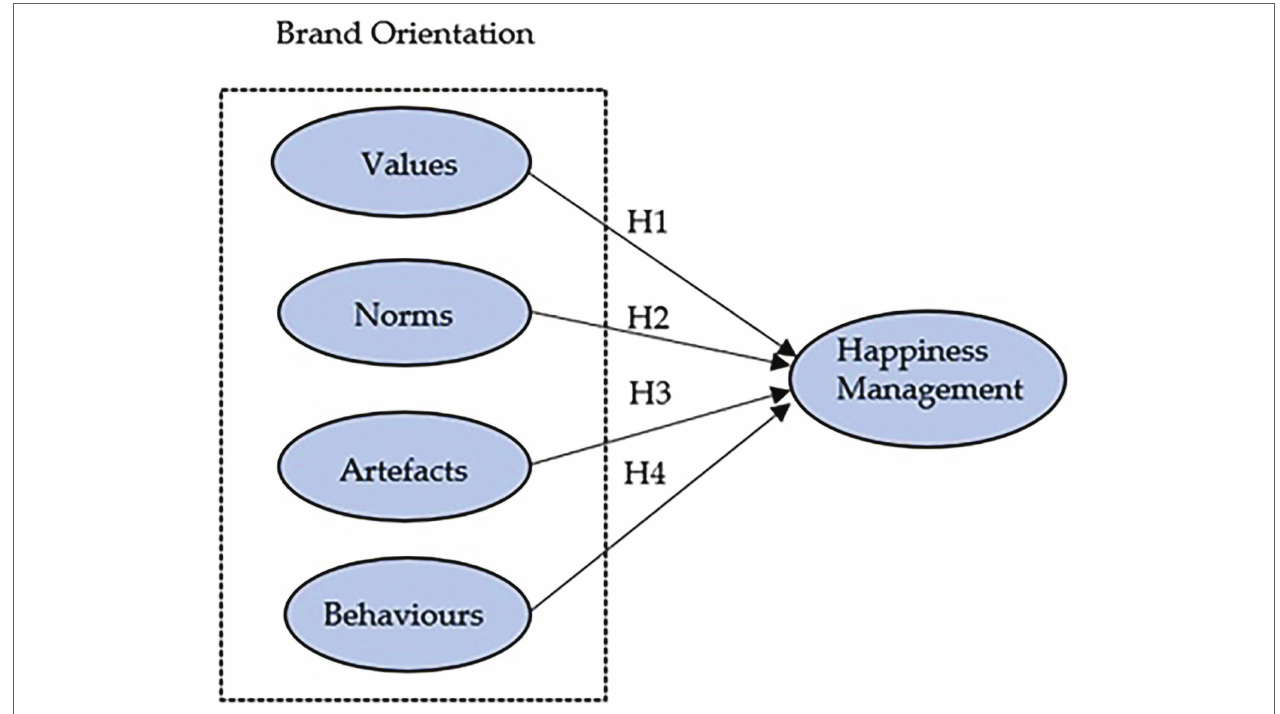
FIGURE 1 | Conceptual model and